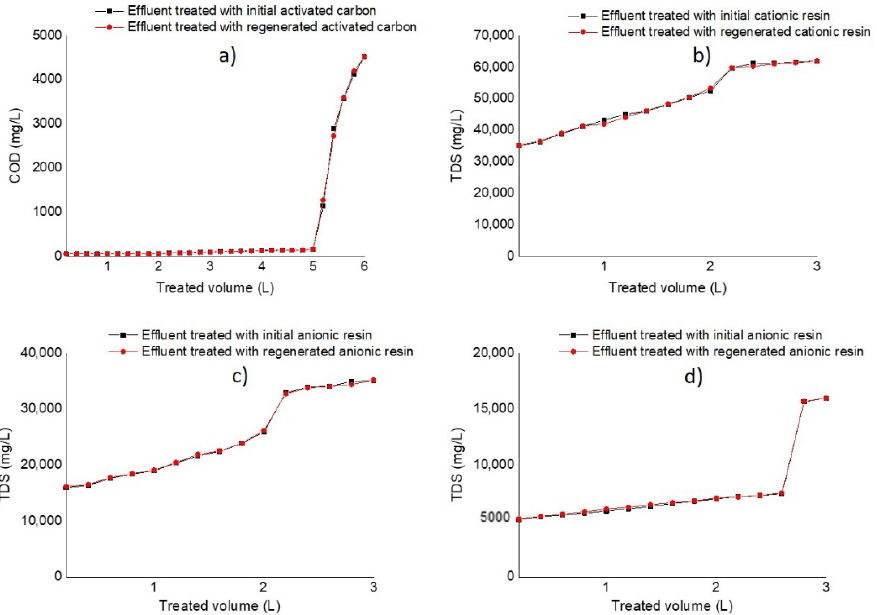
Figure 4. Rupture curves of materials packaging in adsorption and ion exchange columns for 30 and 15 runs of effluent treatment at initial conditions and after their regeneration. ( a ) Activated carbon, ( b ) cationic resin, ( c ) anionic resins in column I, ( d ) anionic resin in column II.